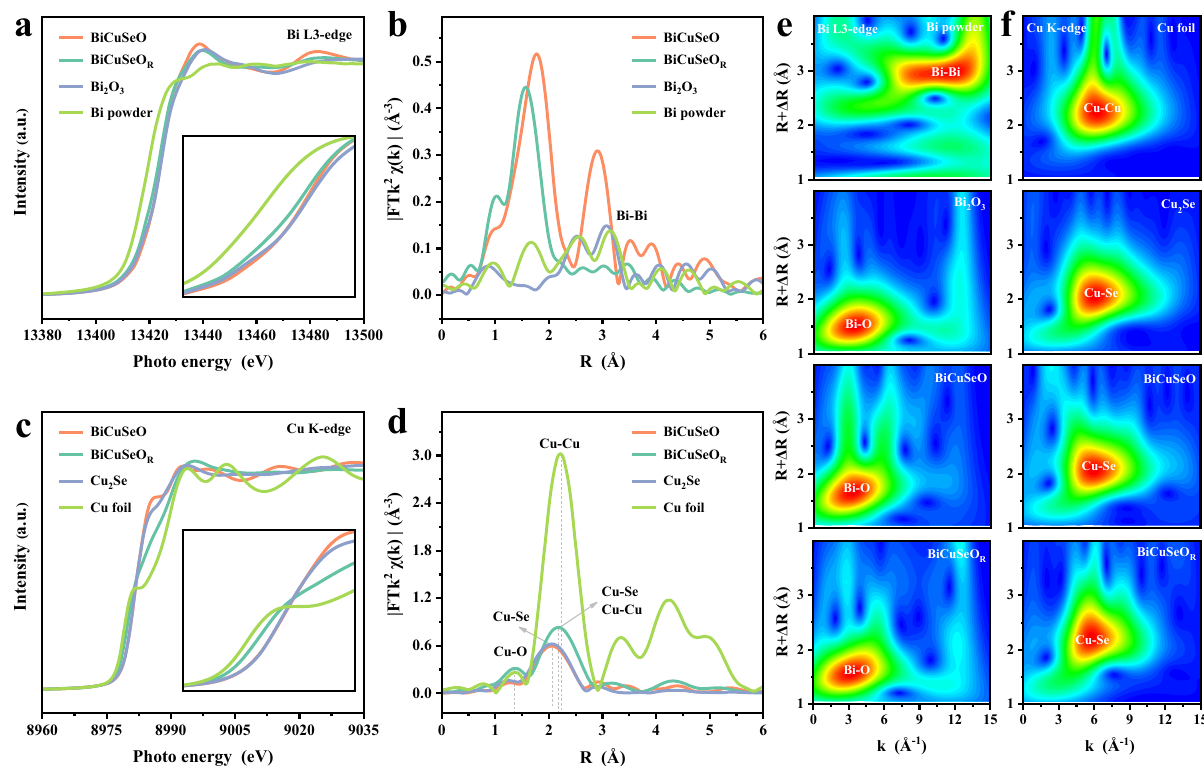
Fig. 4 XAFS characterizations of BiCuSeO after CO 2 RR. a Bi L3-edge XANES and b corresponding FT-EXAFS spectra of BiCuSeO after CO 2 RR. c Cu K-edge XANES spectra and d corresponding FT-EXAFS spectra of BiCuSeO after CO 2 RR. Wavelet transform of the k 2 -weighted EXAFS data of e Bi L3-edge and f Cu Table S6). The Bi – O 2 is attributed to the lattice bond in BiCuSeO,